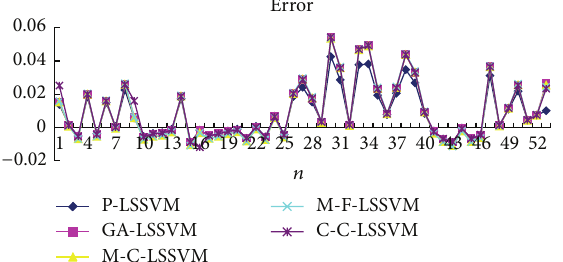
Figure 8: Five models predicted error diagram for FM broadcasting band.